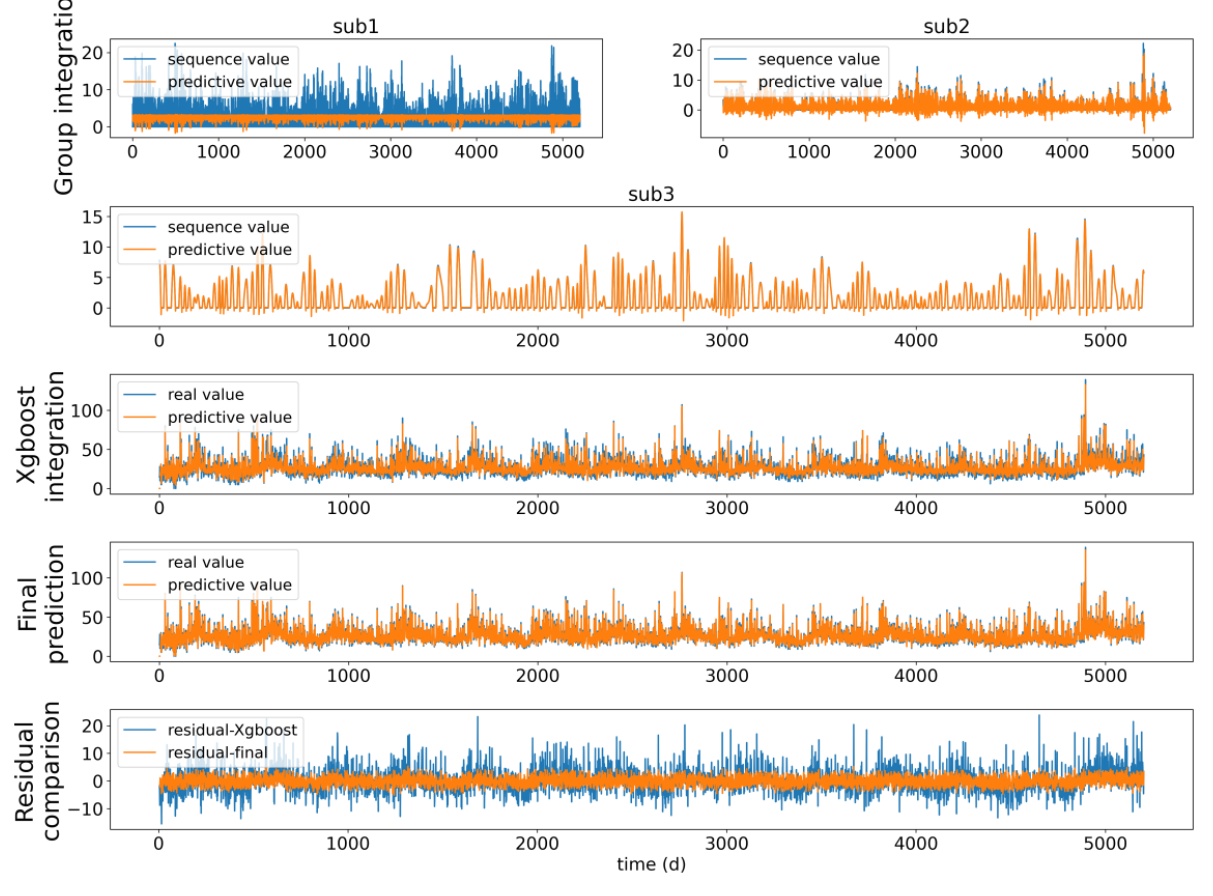
Figure 14. The first three subfigures are the point prediction results of subseries. The fourth subfigure titled “Xgboost integration” shows the integrated results. The fifth subfigure represents the final point prediction results which are generated based on the Xgboost integration and error correction strategy. The last subfigure is the residual comparison between the model with error correction strategy and the model without it. All the experimental results here used data in case 3. Table 5 is the related